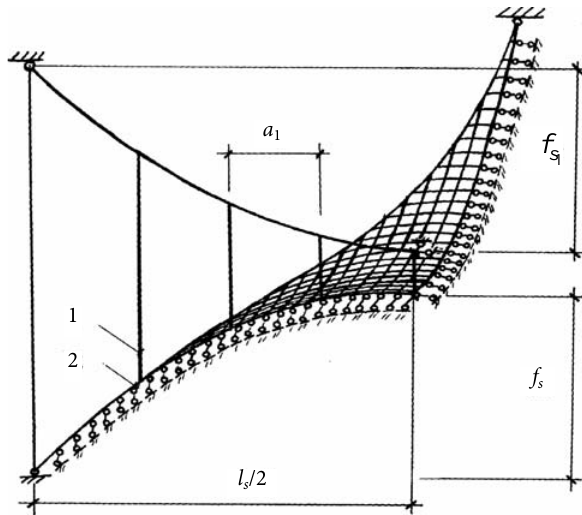
Fig. 8. Design scheme of cable roof: 1 – cable truss; 2 – cable net; f s – initial deflection of cable truss top chord; f s – initial 1 deflection of main stressing cable; a 1 – distance between the support points of